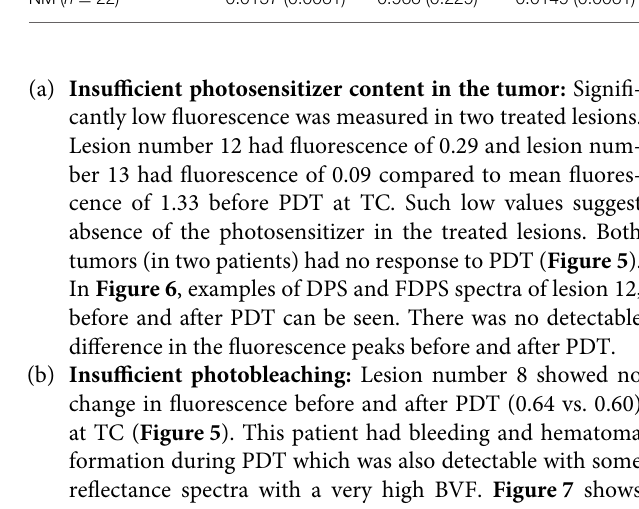
FIGURE 5 | Average mTHPC fluorescence measured in the TC (blue bars; panel A), TM (red bars, panel B), and NM (green bars; panel C). Panel D show the percentage of mTHPC fluorescence photobleached before and after illumination at the TC (blue bars) and TM red bars. Lesions number 12 and 13 show very low fluorescence indicating low concentrations of mTHPC. Lesion number 8 shows no